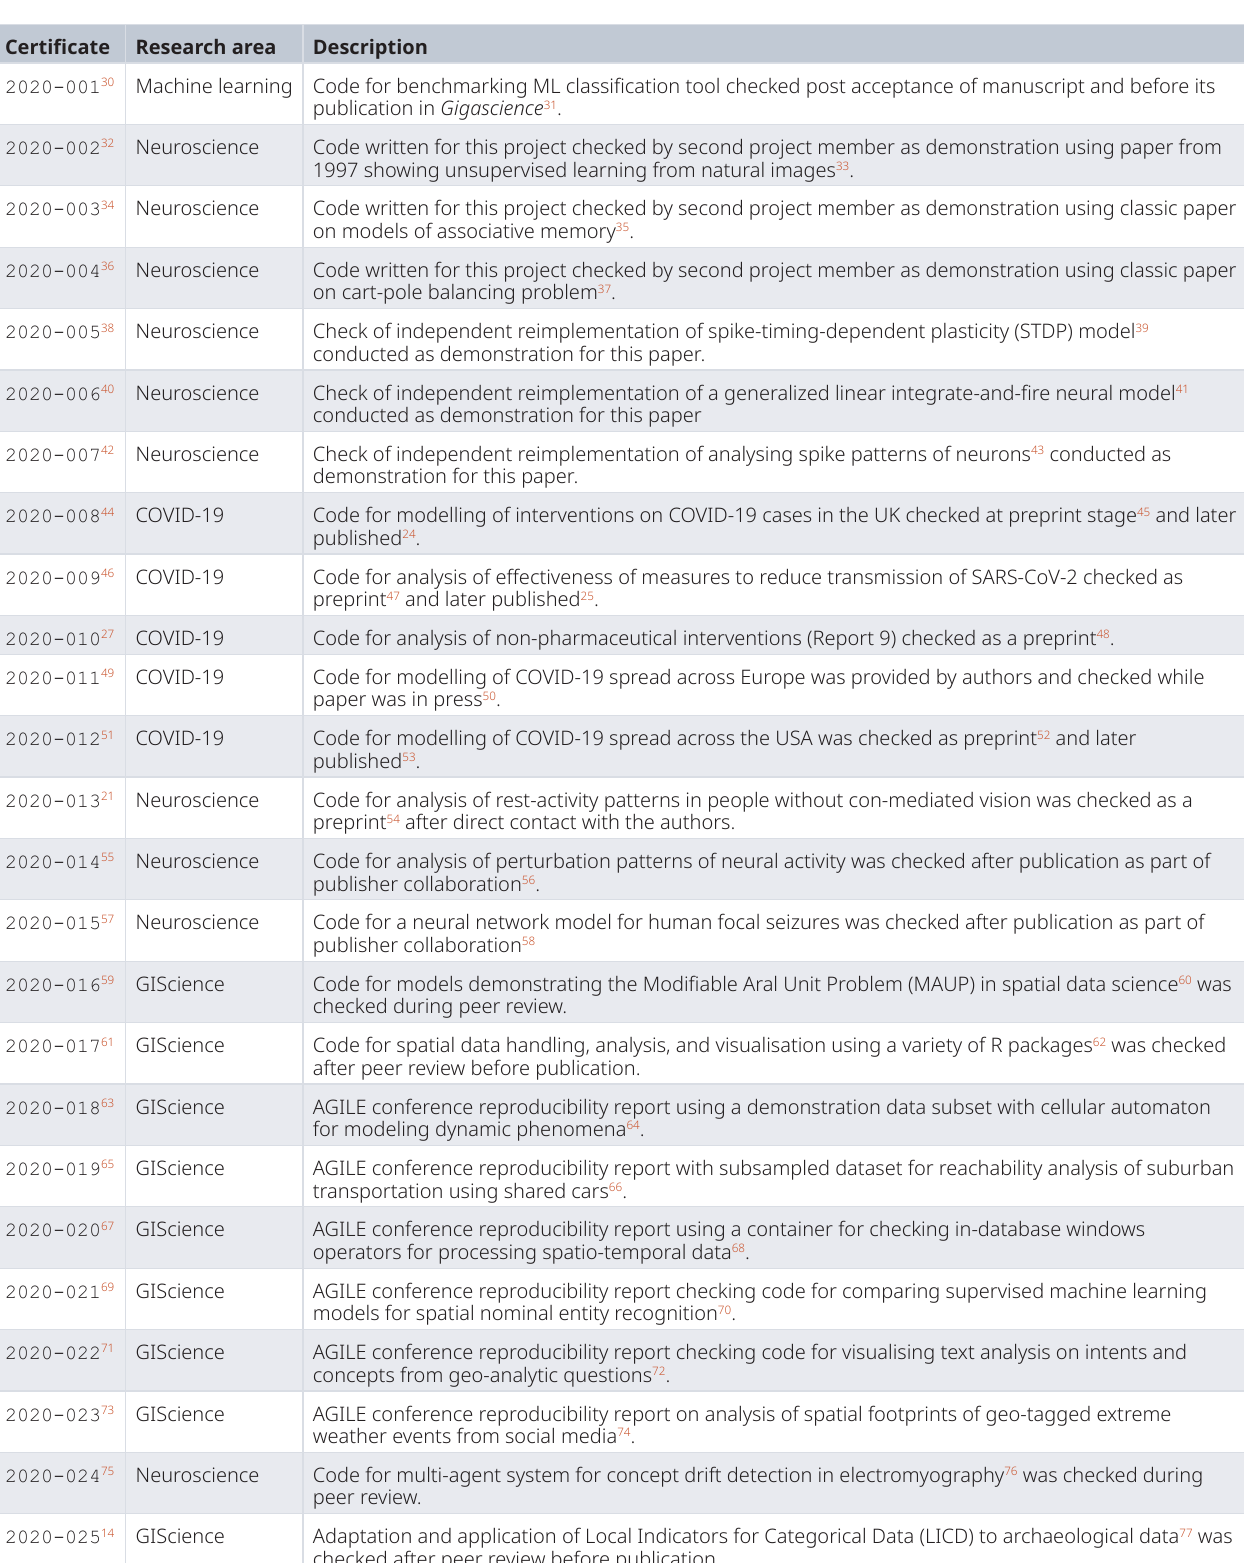
Table 1. Register of completed certificates as of December 2020. An interactive version is available at http://codecheck.org.uk/ register.